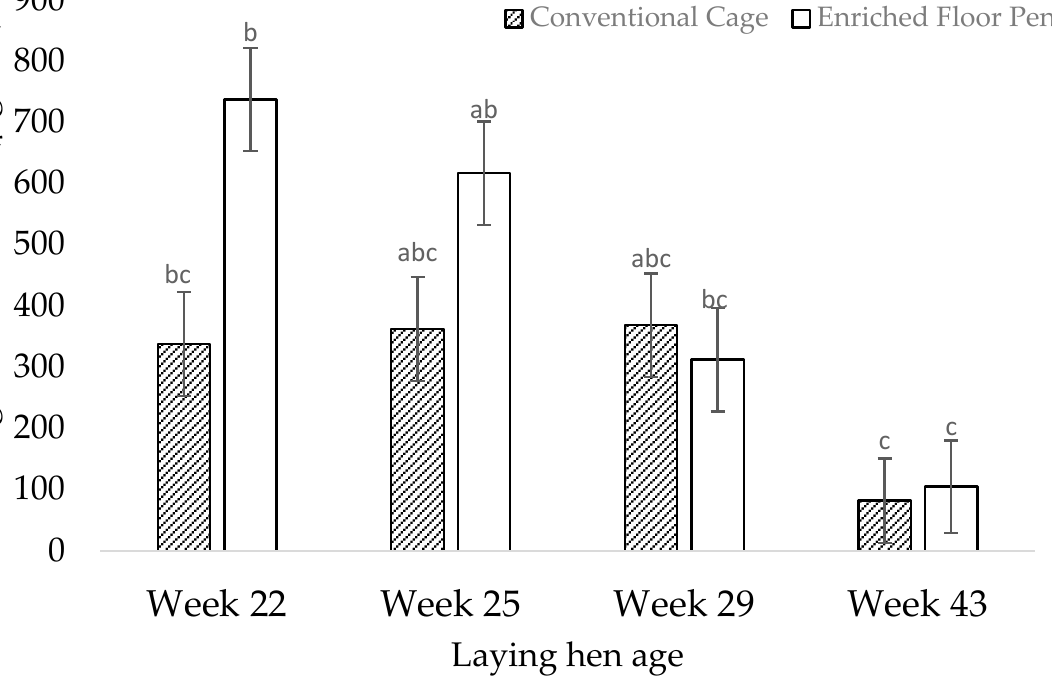
Figure 2. Least square mean estimates (±SEM) of fecal (secretory) immunoglobulin-A (IgA) concen- trations in hens that were housed in conventional cages or enriched floor pens during weeks 22, 25, 29, and 43 of age. Bars lacking a common superscript differ at p < 0.05. Plasma IgA concentrations were not impacted by treatment (F 1,88 = 0.66; p = 0.419) or treatment by week interaction (F 1,48 = − 1.63; p = 0.110). The plasma IgA concentrations were lower in week 22 (87.25 ± 15.65 µ g/mL) compared to week 29 (260.90 ± 15.65 µ g/mL; F 1,88 = − 7.69; p < 0.001) and 43 (201.80 ± 14.45 µ g/mL; F 1,88 = − 5.36; p < 0.001), and lower in week 25 (104.55 ± 16.45 µ g/mL) compared to week 29 (F 1,88 = − 7.00; p < 0.001) and week 43 (F 1,88 = − 4.44; p < 0.001). The plasma IgA concentrations in week 29 were higher than in week 43 (F 1,88 = 2.82; p = 0.030). The feather CORT concentrations by feather weight (ng/mg) were higher in the cage hens compared to the pen hens (F 1,43 = 2.18; p = 0.004; Figure 3). The feather CORT con- centrations were higher in week 22 and 25 compared to week 29 (F 1,43 = 6.07; p = 0.015; Figure 4), but lower in week 29 compared to week 43 (F 1,20 = − 3.30; p = 0.012; Figure 4). There was no treatment by week interaction effect on the feather CORT (F 1,37 = 1.43; p =